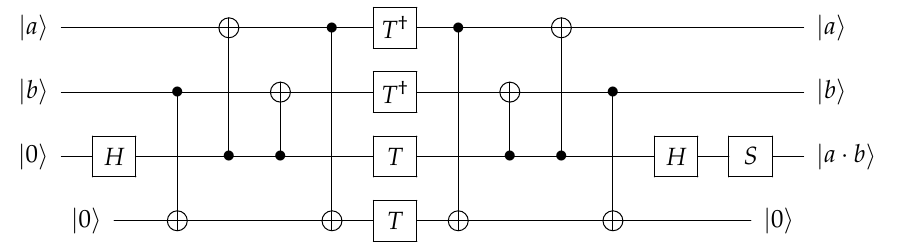
Figure 4. Quantum AND gate.